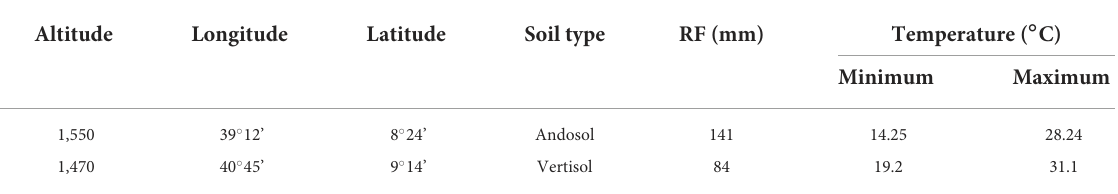
TABLE 1 Description of the experimental sites.